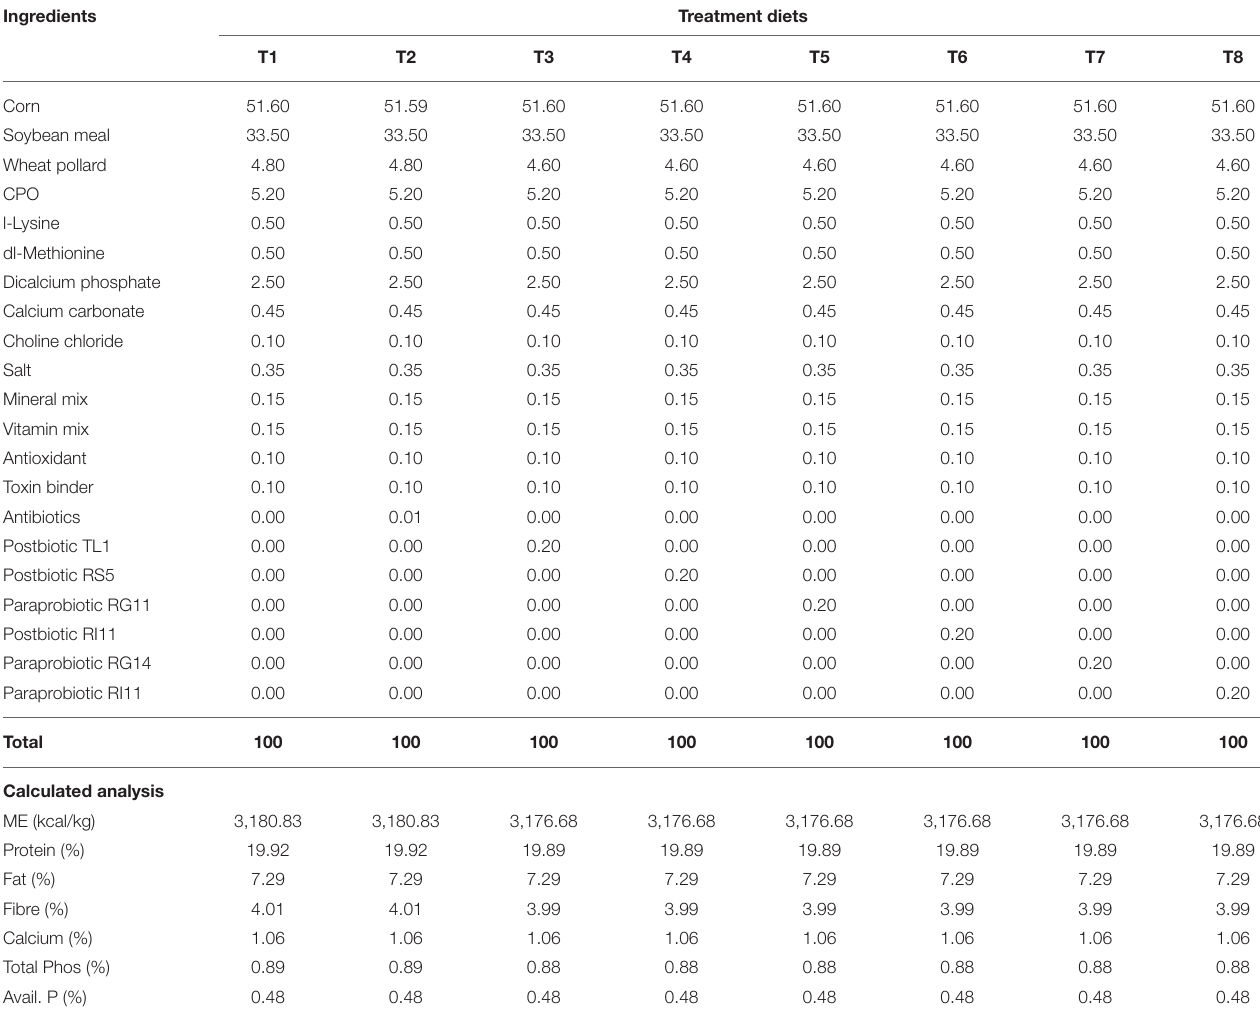
TABLE 2 | Nutrient composition of finisher diets (days